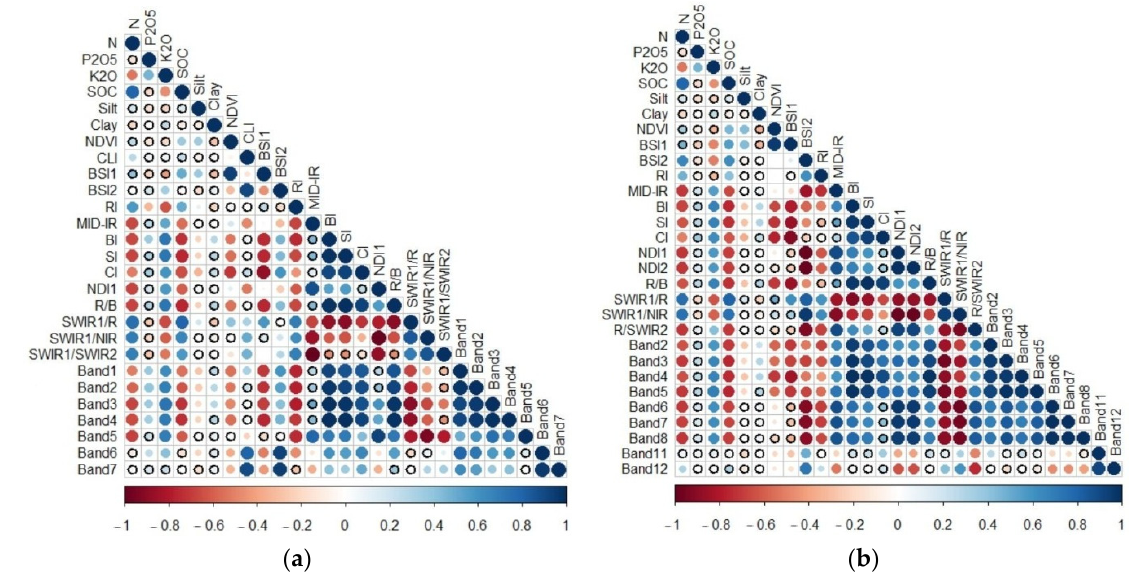
Figure 2. Correlation matrix of soil properties and data from Landsat 8 OLI ( a ) and Sentinel 2 ( b ) satellites. The diameter of the circle shows the size of the correlation; the color shows the direction of the correlation. Significant coefficients of correlation (at p < 0.05) are shown in circles without a black circled line.